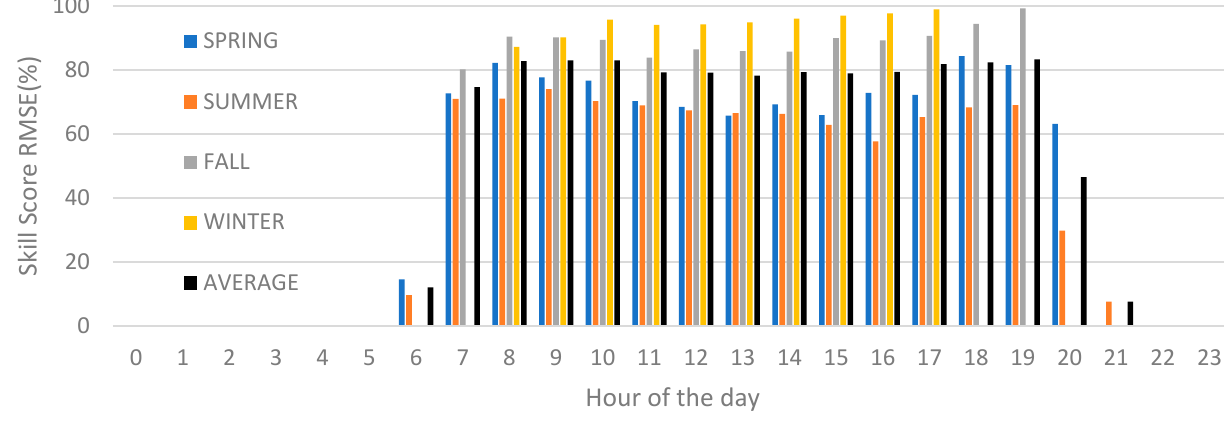
Figure 8. Average skill score RMSE for each hour of the day for the proposed Model S1M. In Figure 8, the average skill score identified from 7:00 a.m. to 7:00 p.m. for all